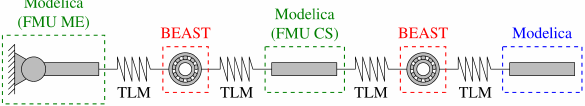
Figure 6: The modelling tools used for the different external models and the couplings between them (FMU ME = FMU for model exchange, FMU CS = FMU for co-simulation, “no no- tation” indicate direct